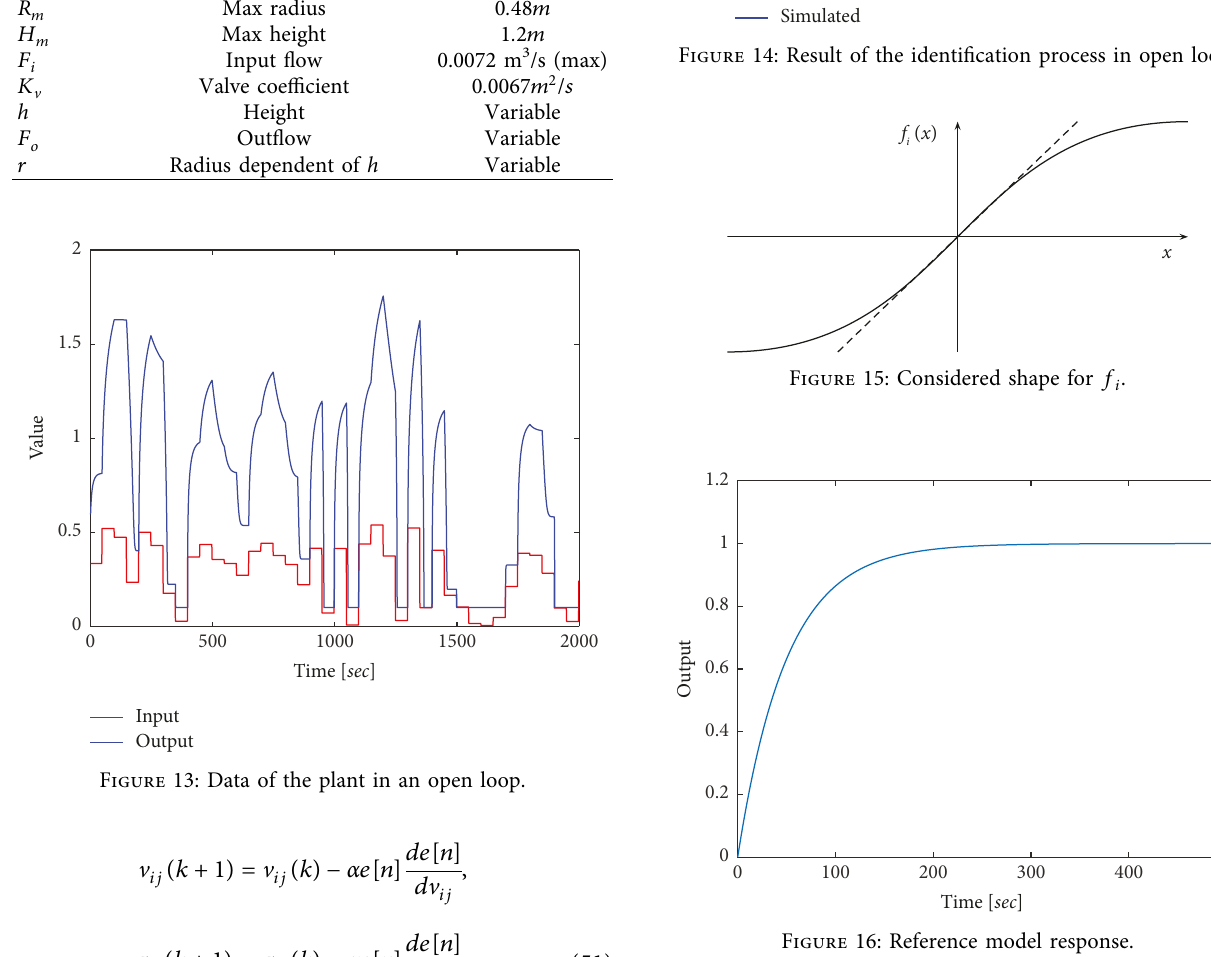
Figure 12: Block diagram associated with the conical tank. Table 3: Conical tank parameters. Parameter